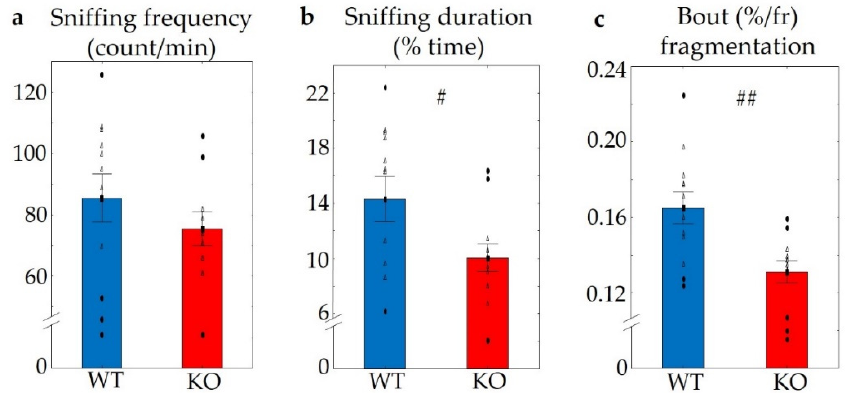
Figure 9. Results of the social interaction test. No differences were detected in the frequency of social behaviour between the two genotypes ( a ); however, a decreased duration of sniffing ( b ) and bout fragmentation ( c ) were detected in KO mice. n = 12 in both groups, the symbol # shows a significant difference, in cases with # p < 0.05, and ## p < 0.01. Blank triangles represent individual values while dark spots show outliers (characterized by a higher or lower value than mean ± 2 standard deviation (SD)).